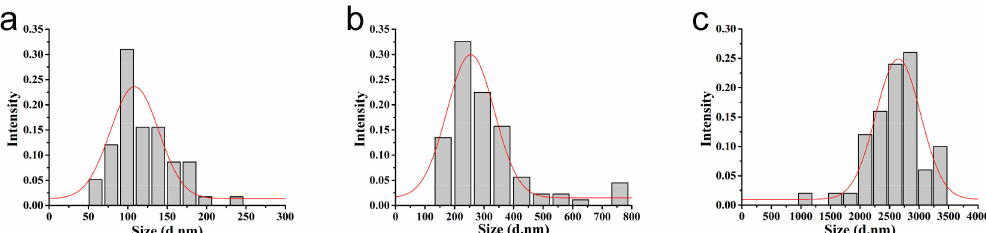
Figure 5. Transmission electron microscopy (TEM) morphologies of the azoxystrobin microspheres. ( a ) MS1; ( b ) MS2; ( c ) MS3.